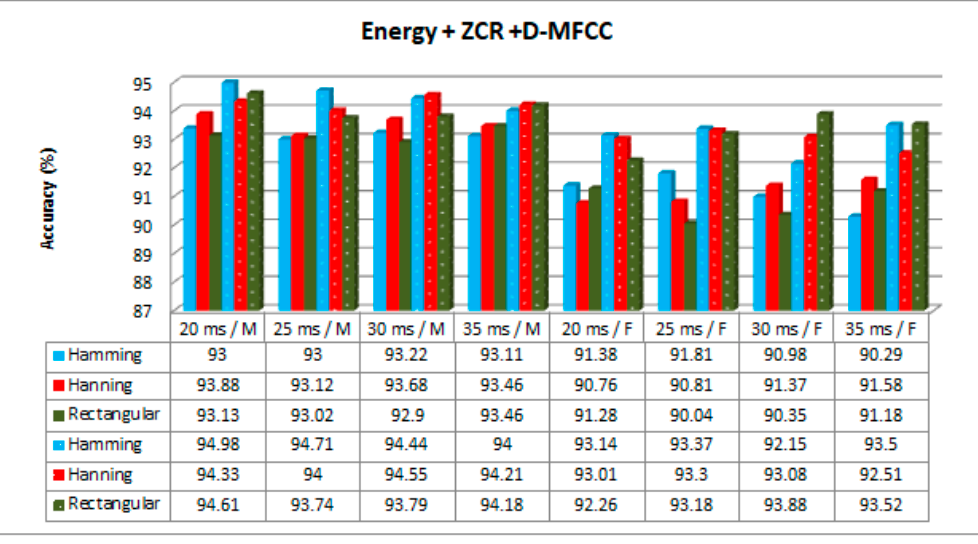
Figure 11. EZDDMFCC accuracy results without GRU-based training (no dotted bars) and with GRU-based training (dotted bars) using a CNN classifier for male (M) and female (F) speakers. In this study we used various combination parameters, and the models are summarized in Table 11. Table 11. Feature parameter sets and models. GRU Based Training Model Male and Female Hybrid Features